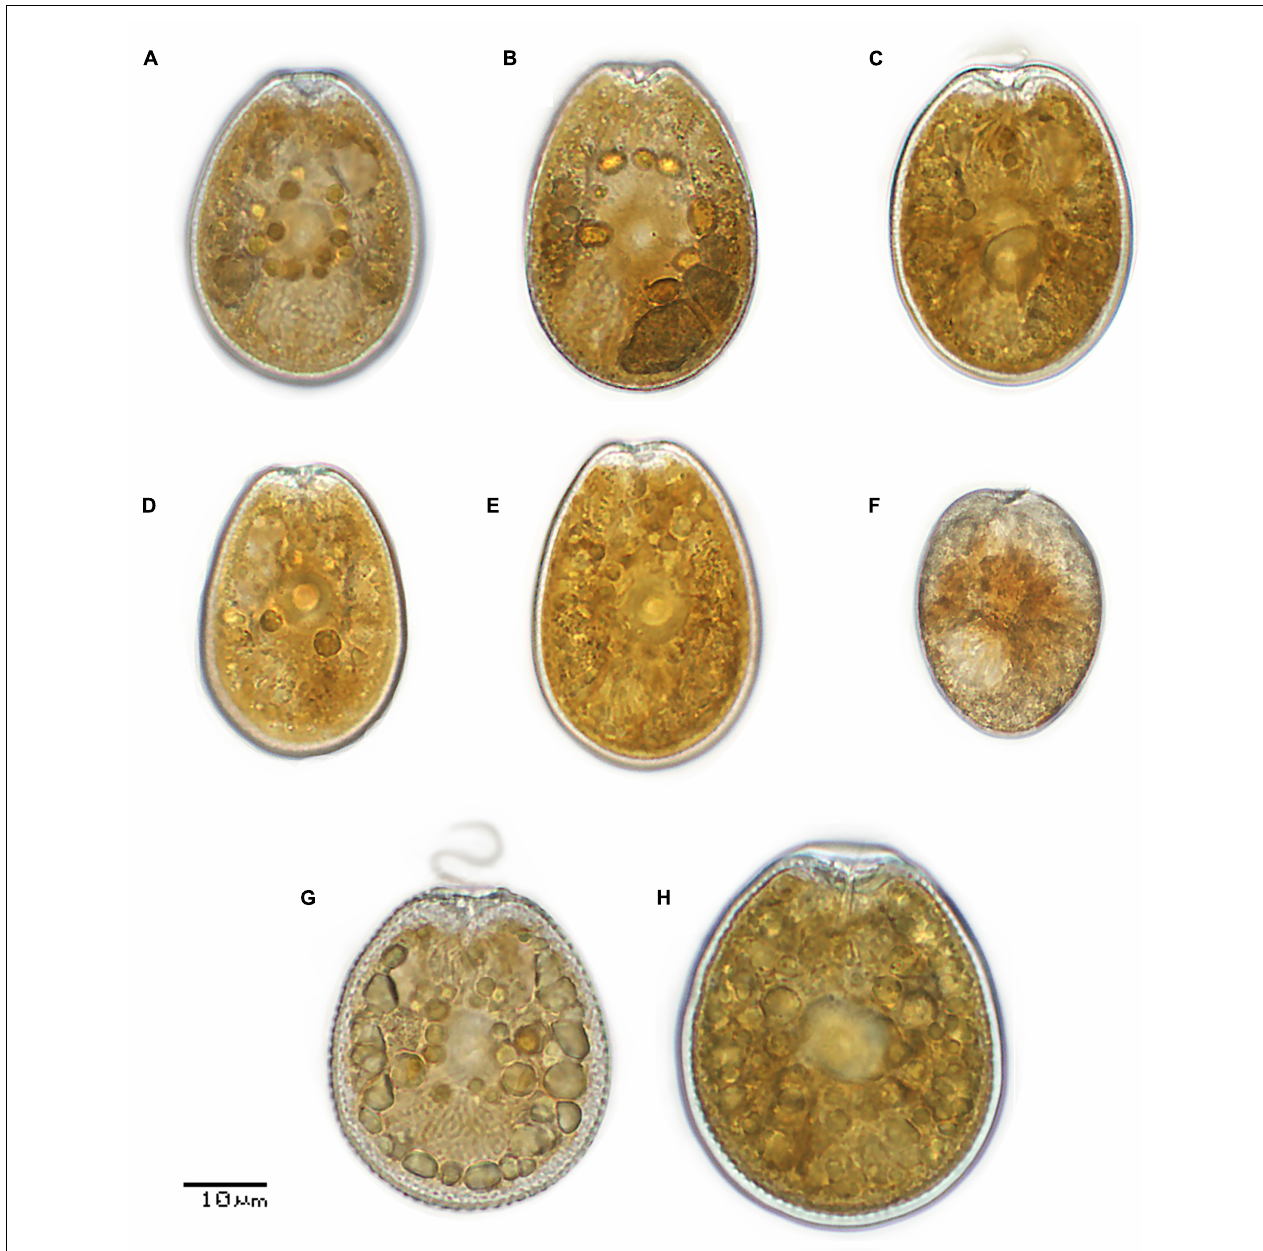
FIGURE 2 | Light micrographs of selected isolates of Prorocentrum species as representative for major clades: (A–E) P. lima morphotypes (PLSC) (PA1, PA8, PA9, PA48, and PA72, respectively) in right thecal view; (F) P. rhathymum (PA20) in left thecal view; (G,H) P. hoffmannianum (PA89 and PA70) in right thecal view. In all isolates a central ring-shaped pyrenoid can be distinguished. The posteriorly located nucleus with visible chromosomes can be seen. In most illustrated cells from the PLSC (A,B,E,F) and P. hoffmannianum (G,H) the maximum cell width is situated below the median line, closer to the posterior end, whereas for PLSC isolate PA9 (C) and P. rhathymum (F) it is at the median